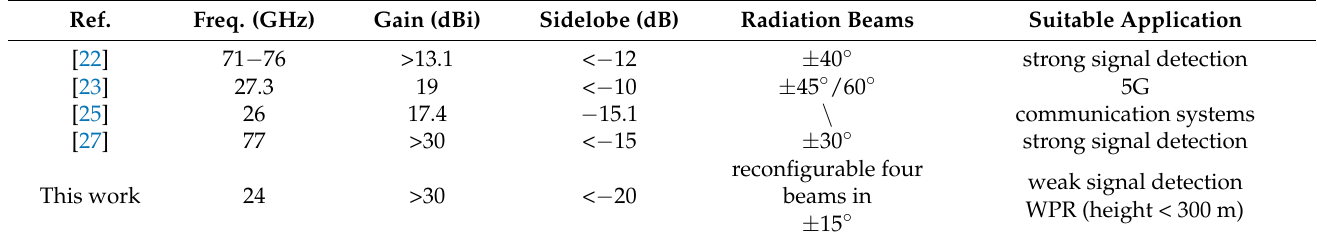
Table 1. Comparison with other relative